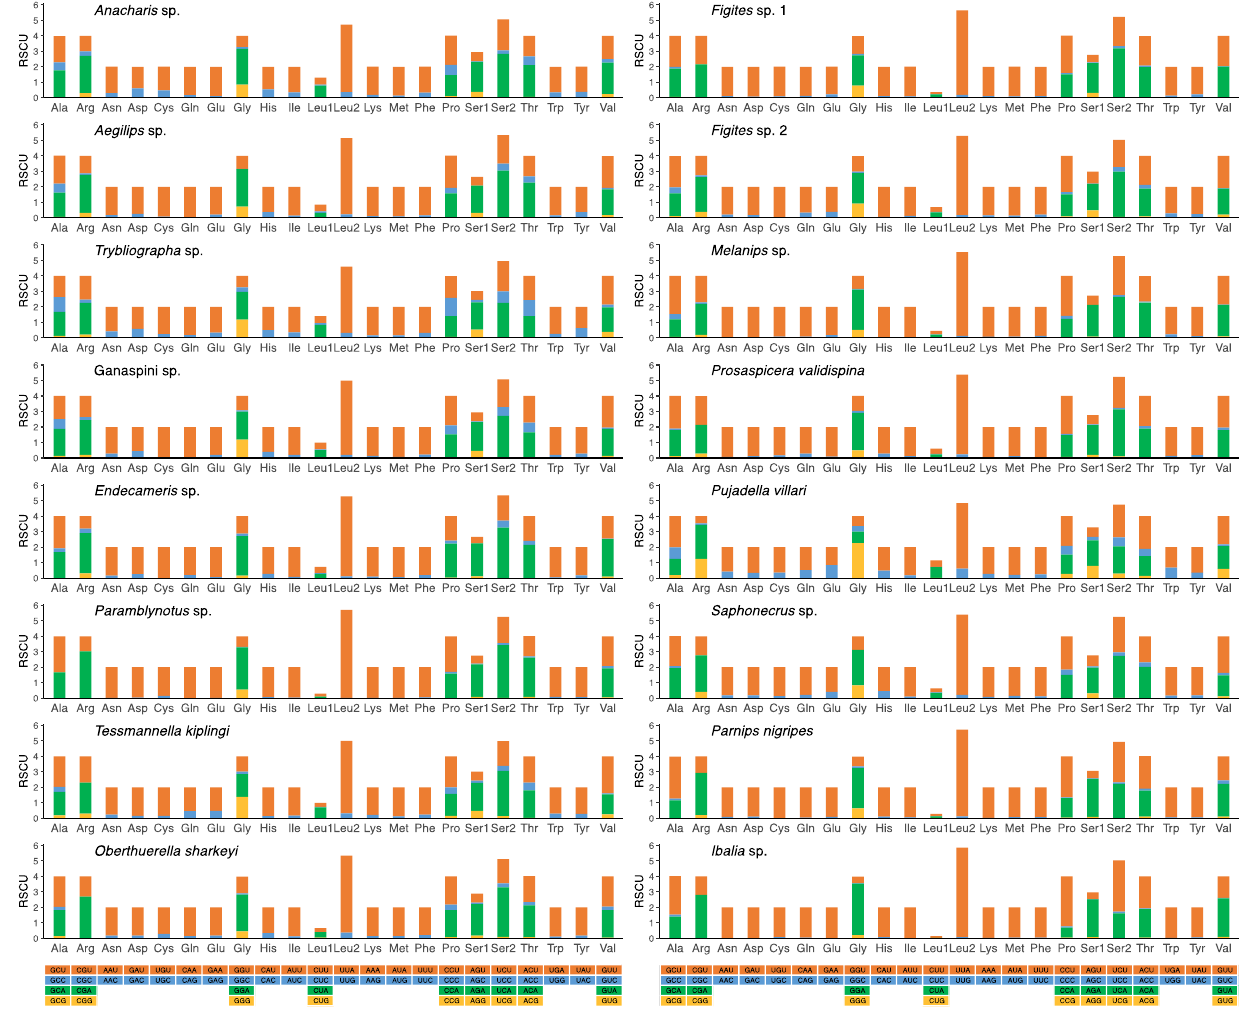
Figure 2. Relative synonymous codon usage (RSCU) of 16 cynipoid mitogenomes. Codon families are provided on the X-axis along with the different combinations of synonymous codons that code for that amino acid. RSCU is defined on the